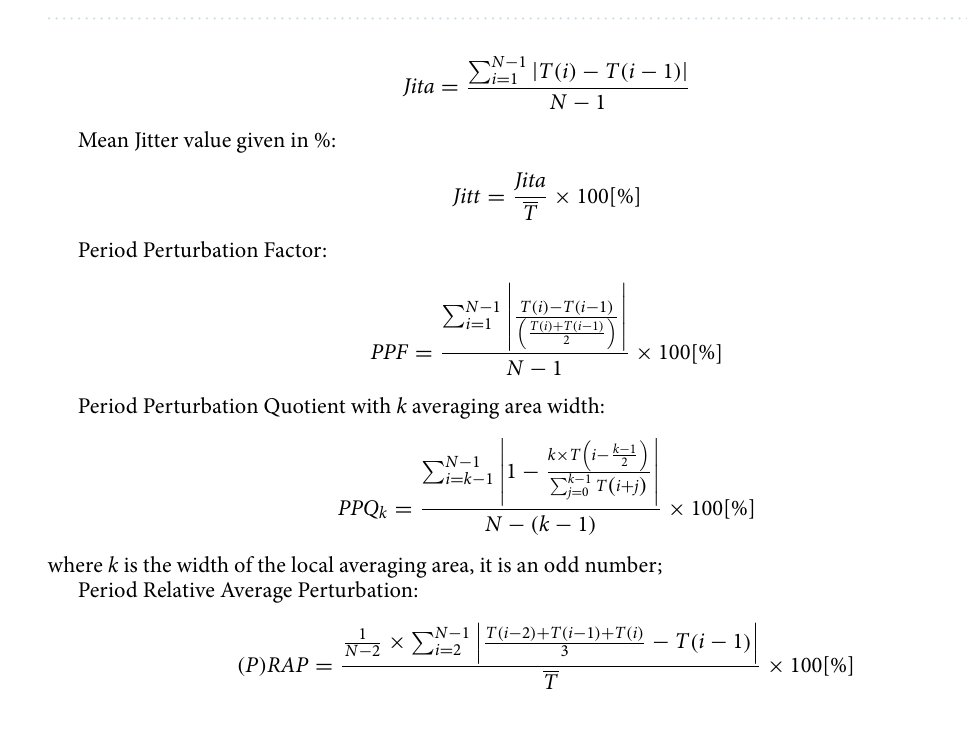
Figure 6. Analysis of HSV data of phonatory onset acquired by means of rigid endoscope for Subject 2. ( A ) Videokymogram; ( B1 ) Comparison of the glottal width waveform obtained from a videokymogram (green line) and the audio signal oscillogram (blue line); ( B2 ) Glottal width waveform with marked closures of glottis; ( C ) Comparison of F0 for obtained from a videokymogram (green line) and acoustic voice analysis (blue